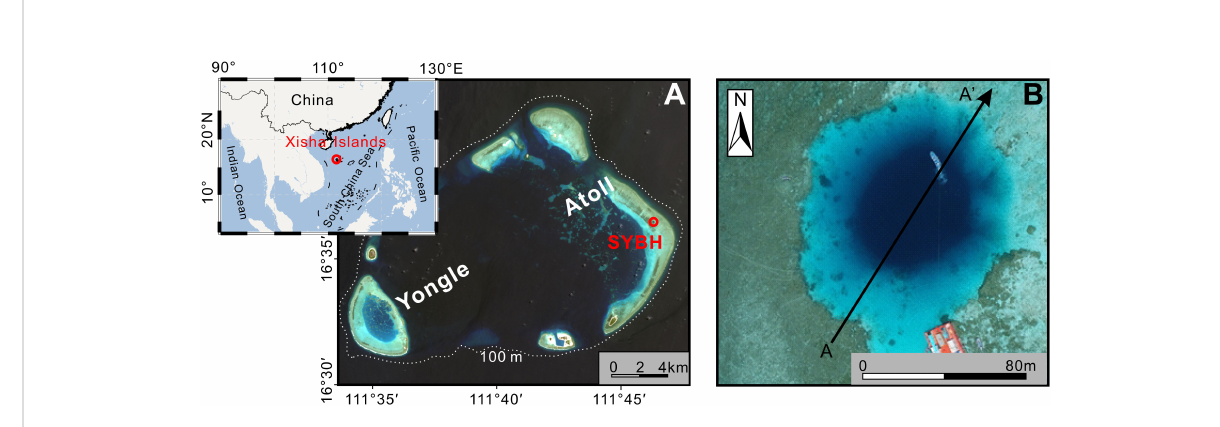
FIGURE 1 Location map (A) and aerial photography of Sansha Yongle Blue Hole (B) in Yongle Atoll, Xisha Islands, South China Sea. The A – A ′ cross-section line in the right panel represents vertical pro fi les of Figure